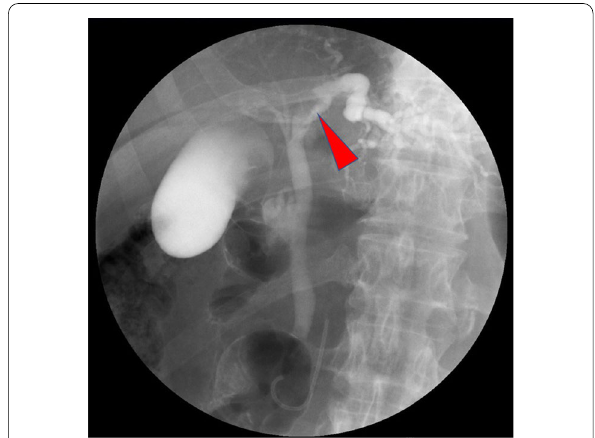
Fig. 2 Endoscopic retrograde cholangiography. The arrowhead indicates a filling defect in the left hepatic duct. Simultaneously, bile duct brushing cytology was performed, but a clear diagnosis was not